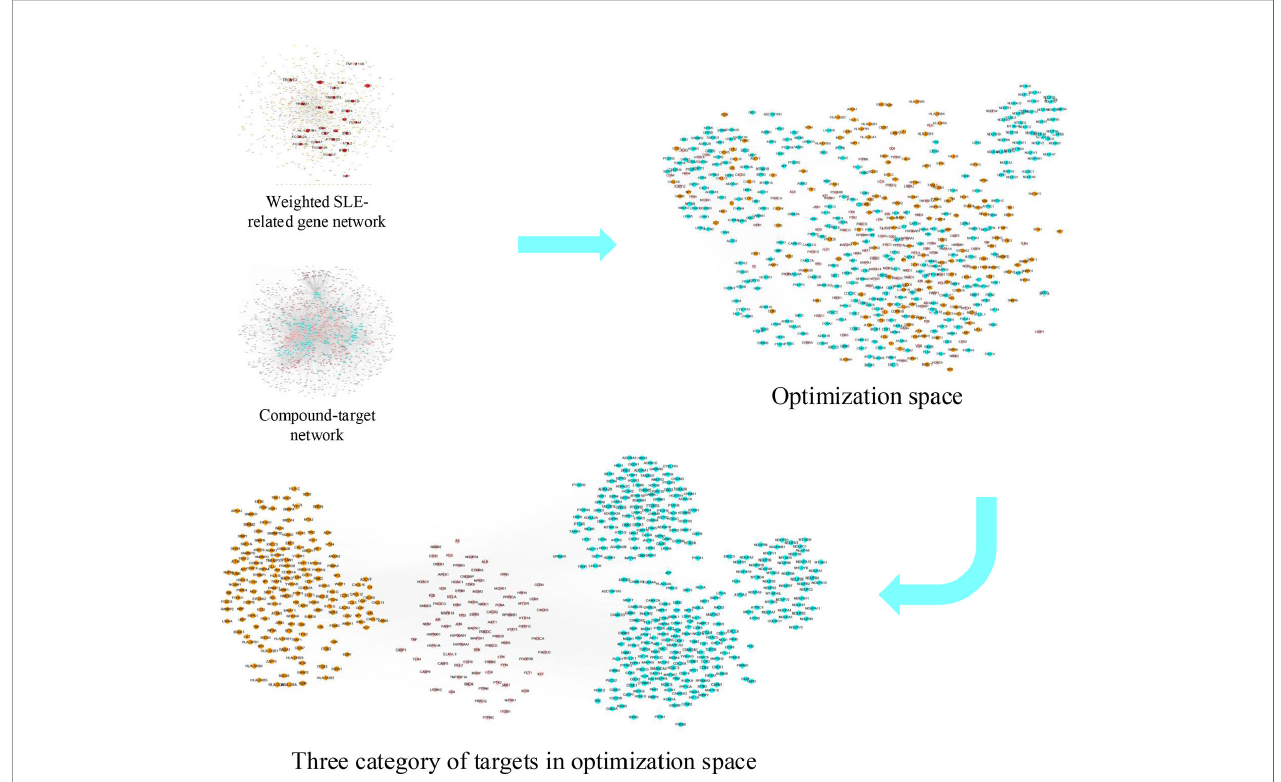
FIGURE 5 | Optimization space construction. Optimization space includes three category targets, pink nodes represent essential common targets, orange nodes represent disease-speci fi c targets, cyan nodes represent component-speci fi c